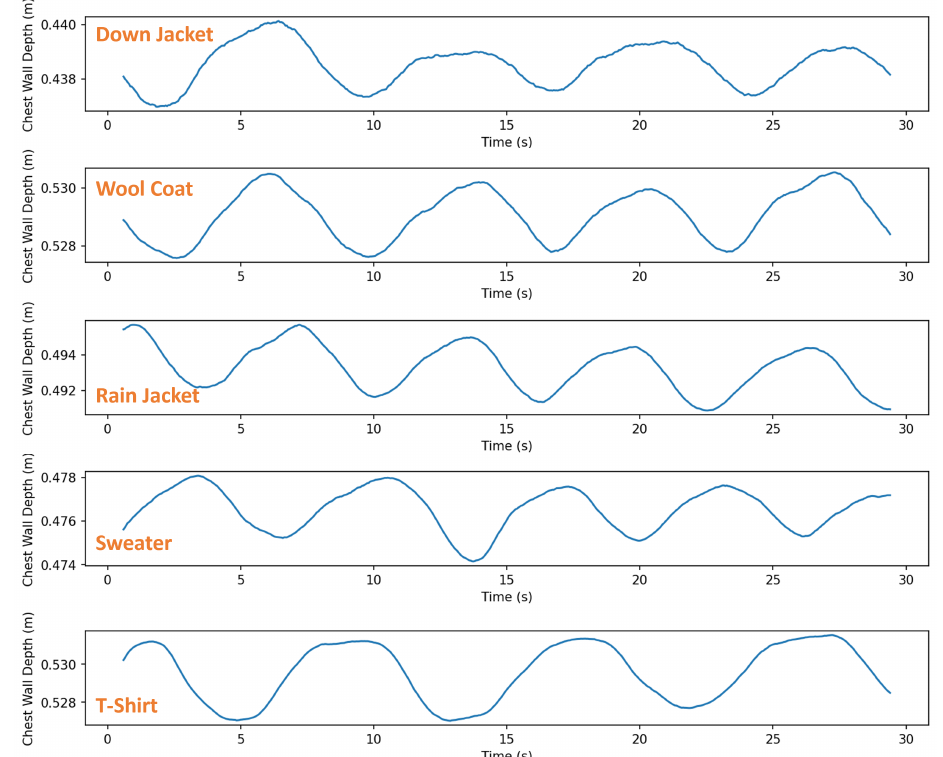
Figure 25. Respiration motion on chest measured by the ToF camera while the participants were wearing different types of clothing. Clear respiration patterns can be seen in all